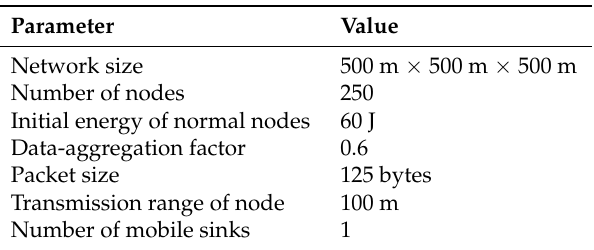
Table 3. Simulation